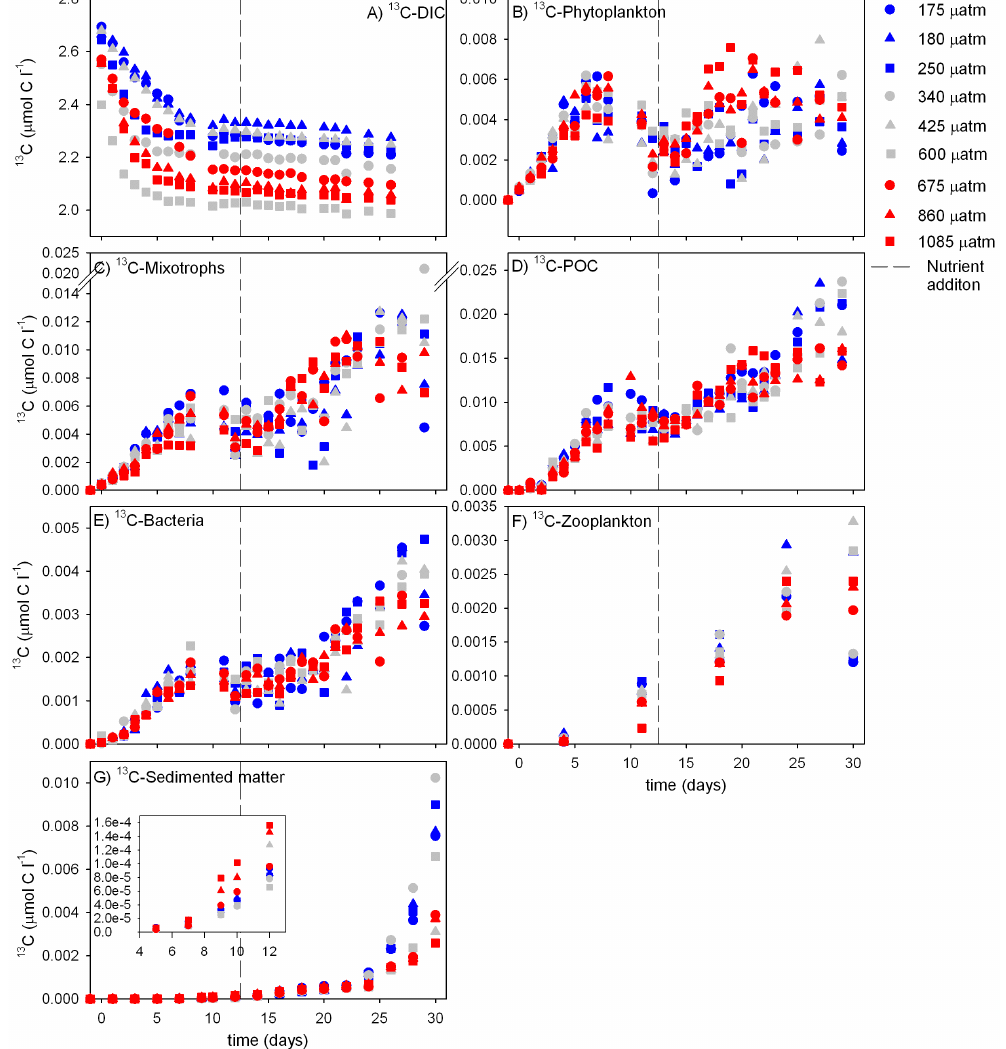
Fig. 2. Temporal development of 13 C in stocks and 13 C labelled biomass (µmol 13 CL − 1 ) of (A) DIC; (B) phytoplankton; (C) mixotrophs; (D) POC; (E) bacteria; (F) zooplankton ( Calanus sp.); and (G) sedimented organic matter in each mesocosm. Red colours are used for high p CO 2 treatments, grey for medium, and blue for low p CO 2 treatments. The vertical line denotes the timing of nutrient addition. The inset of (G) zooms in on the first